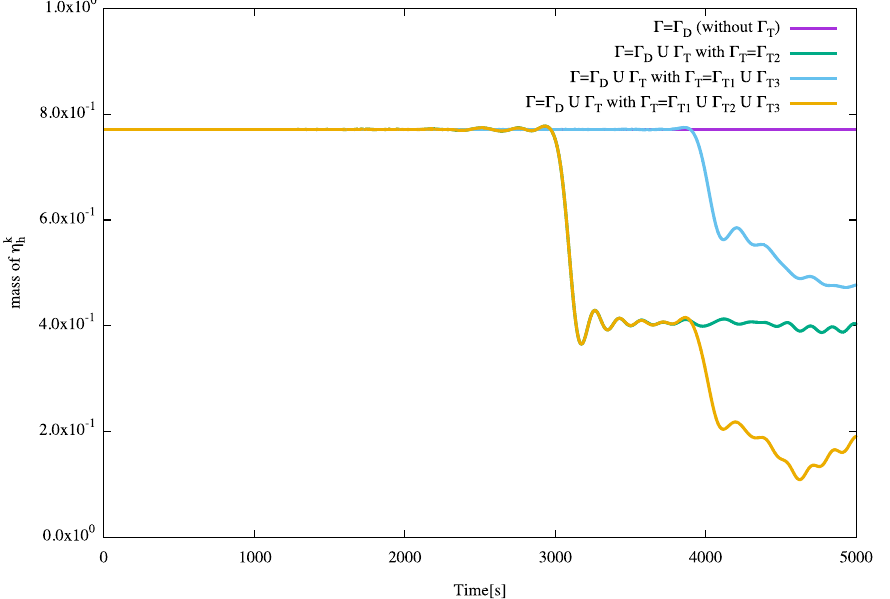
Figure 12. Graphs of the mass of η n with respect to time ( t = t n ) for Example 4 with the fol- h lowing four settings; no transmission boundary, i.e., Γ T = ∅ (purple), one transmission boundary, i.e., Γ T = Γ T2 (green), two transmission boundaries, i.e., Γ T = Γ T1 ∪ Γ T3 (blue), and three transmission boundaries, i.e., Γ T = Γ T1 ∪ Γ T2 ∪ Γ T3